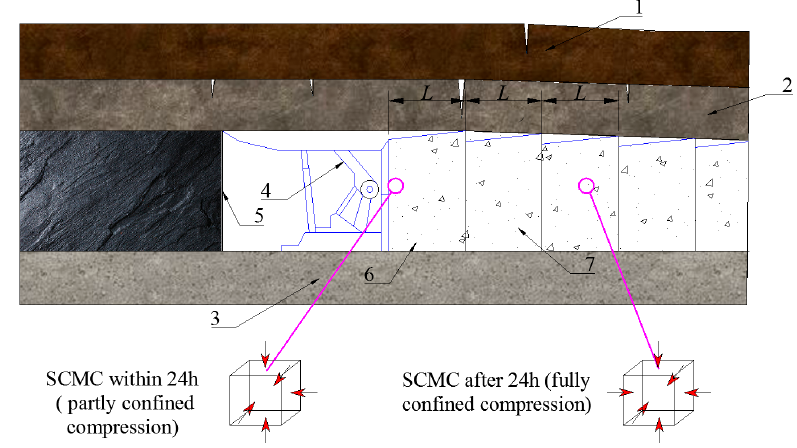
Figure 4. Compression State of the backfilled SCMC. 1-main roof; 2-immediate roof; 3-floor; 4-hydraulic support; 5-coal body; 6-SCMC within 24 h; 7-SCMC after 24 h; L -width of pocket.